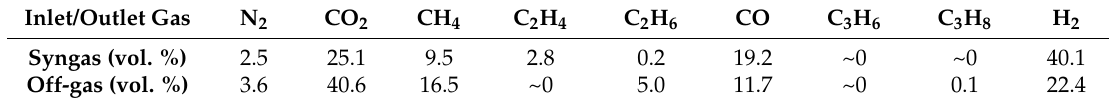
Table A2. Average composition of Inlet/Outlet Gases under CL condition [12].